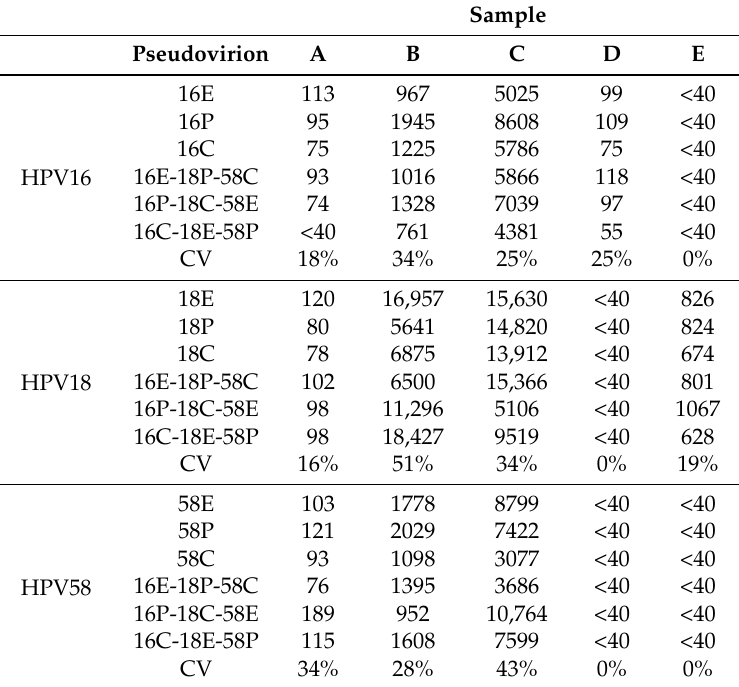
Table 1. Comparison of the single- and three-color PBNAs in detecting antibody titers.